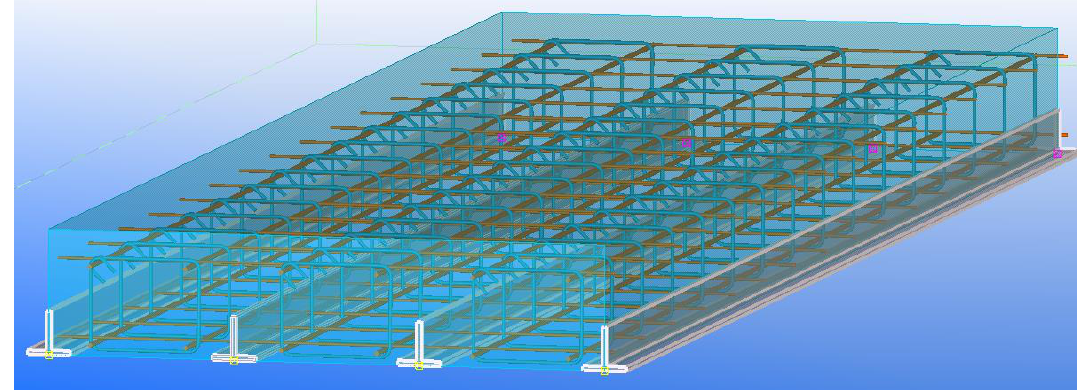
Fig. 2 . Modified steel beams in steel-concrete composite structure.